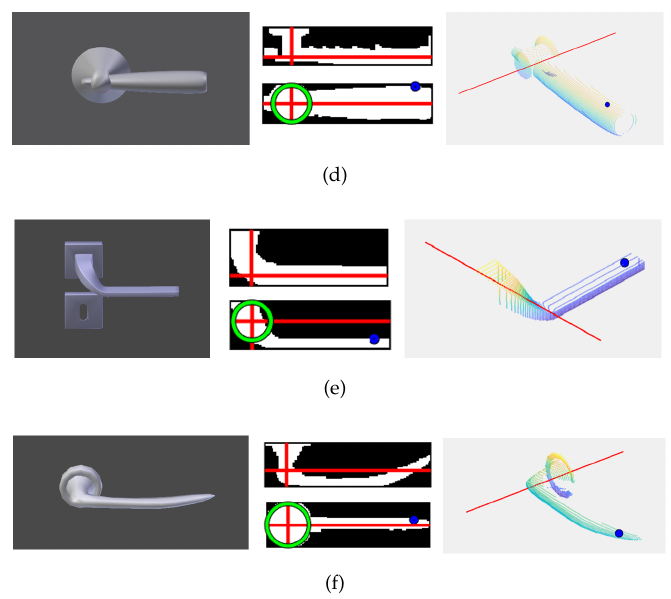
Figure 9. (a–f) Some of the most representative cases of the simulated door handles (left), with both top and frontal projections (middle) and the final point cloud with the axis of rotation Ω h and contact point P h (right).